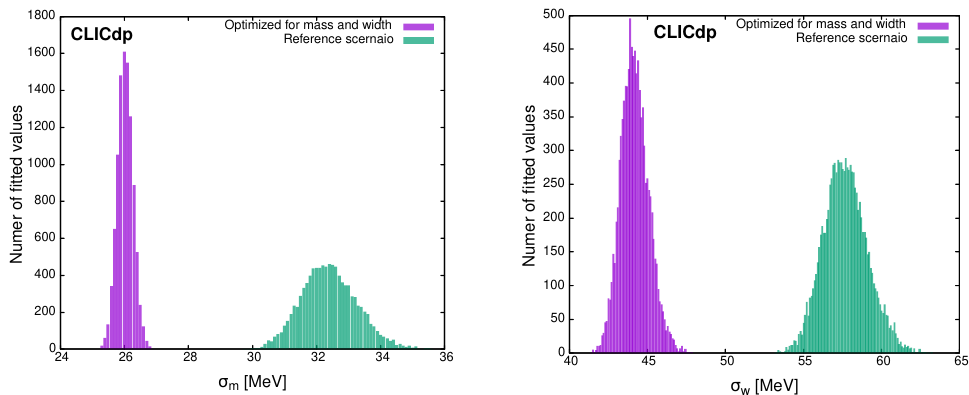
Figure 3: Scan points of the “best scenarios” selected from the last generation com- pared with the reference cross section template: (left) for mass and width measure- ment optimisation (5 point scenario: two points below, two in the middle and one above the threshold) and (right) for mass and Yukawa coupling measurement opti- misation (10 point scenario). Figure reproduced from [ 2 ] .